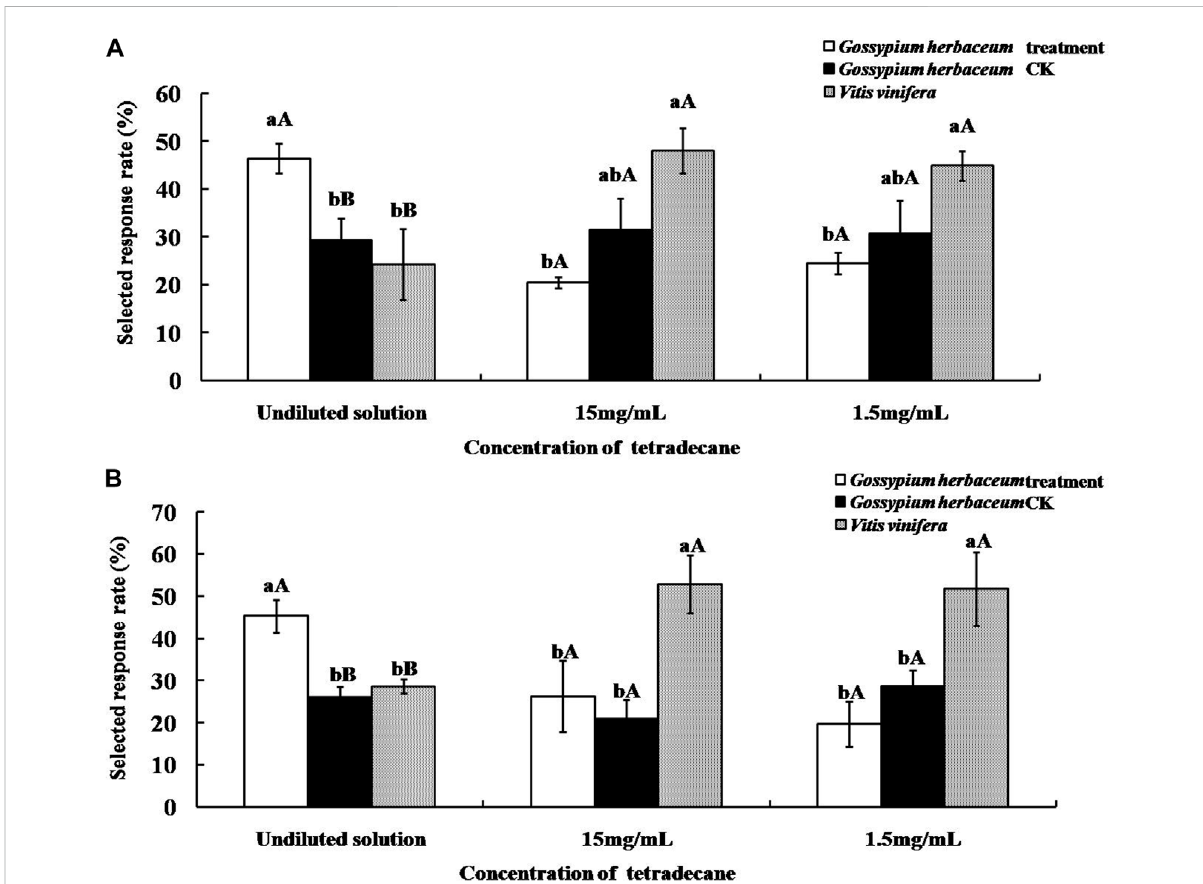
FIGURE 6 Selected response rates of Apolygus lucorum (A) and Adelphocoris suturalis (B) to host plants supplemented with tetradecane. Different uppercase and lowercase letters showed highly signi fi cant ( p < 0.01) and signi fi cant ( p < 0.05) differences in the selected responserate of mirid bugs to different hosts treated by tetradecane of different concentration respectively ( Least Signi fi cant Difference test